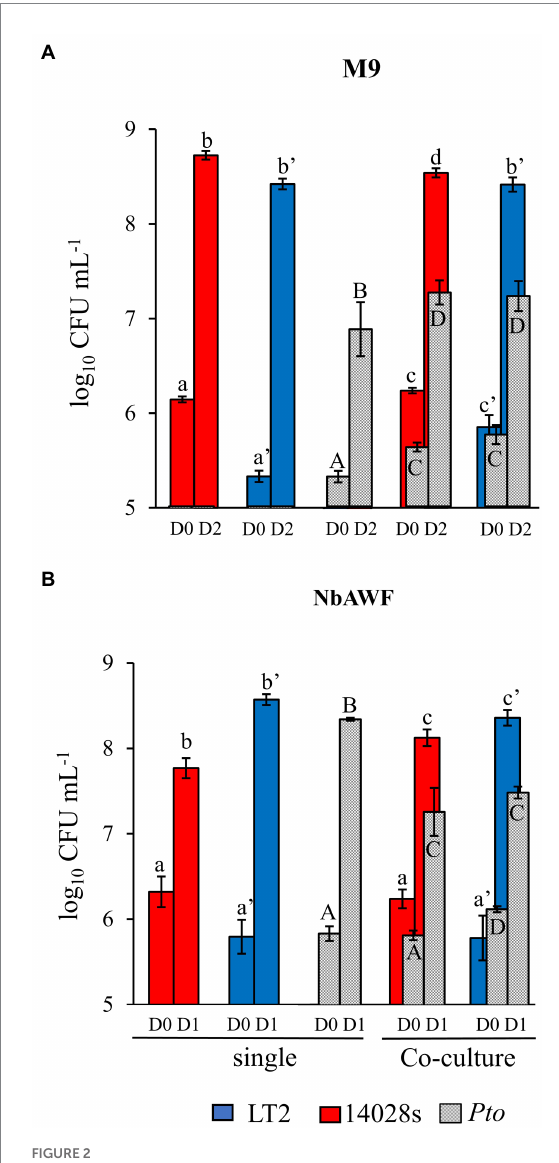
FIGURE 2 Salmonella enterica is competent for competition with P. syringae during co-culture in ex planta N. benthamiana apoplastic wash fluid. Bacterial populations of P. syringae ( Pto , grey) and S. enterica strains LT2 (blue) and 14028s (red) after inoculation in (A) M9 glucose medium (M9) and (B) N. benthamiana apoplastic wash fluid (NbAWF). Bacterial populations were measured as log colony forming units per mL of culture (log 10 CFU mL − 1 ) on day 0, 1, and 2. Data are means ± SD ( n = 3–5). Different letters indicate significant differences (2- way ANOVA for each strain at p < 0.05). Asterisk indicates significant difference between co-inoculation partners (2 tailed t -test at p < 0.05). Two independent experiments were conducted with similar results.